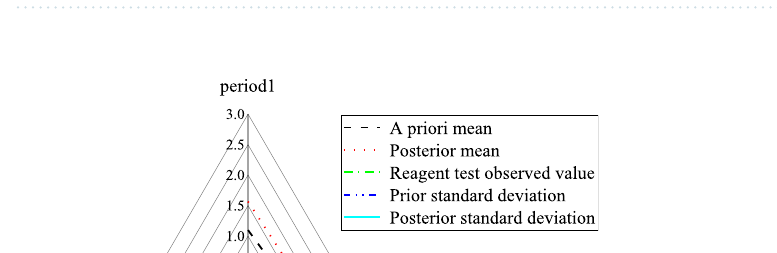
Figure 5. Mask supply of 3 manufacturers in 3 cities.